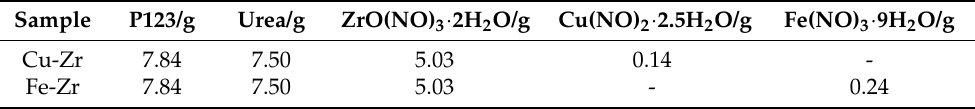
Table 3. The chemical dosage used during for the synthesis of Cu-Zr and Fe-Zr